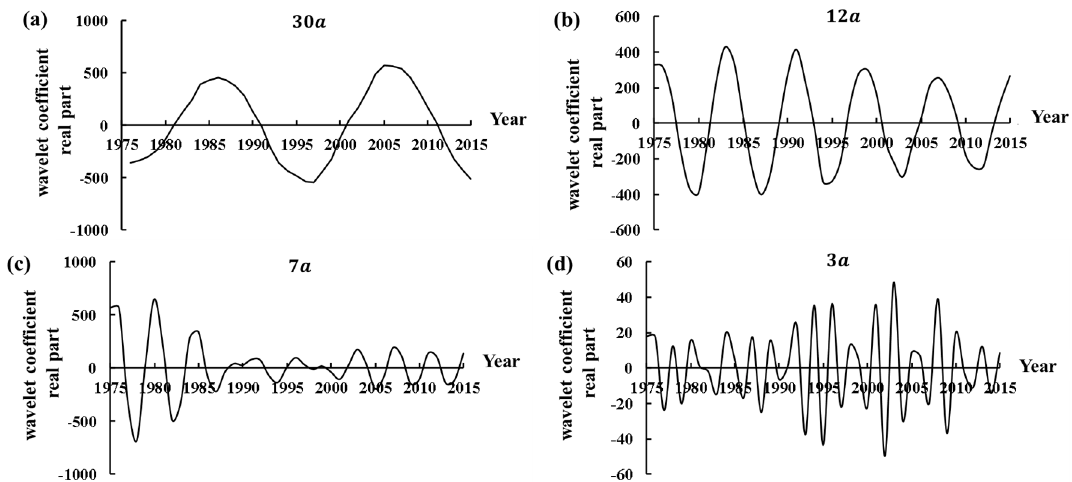
Figure 9. Real part variation process of annual sediment anomaly series wavelet coefficients. ( a ) Time scale of 30 a ; ( b ) Time scale of 12 a ; ( c ) Time scale of 7 a ; ( d ) Time scale of 3 a . Table 3. Analysis results of runoff time series different characteristic time scales.